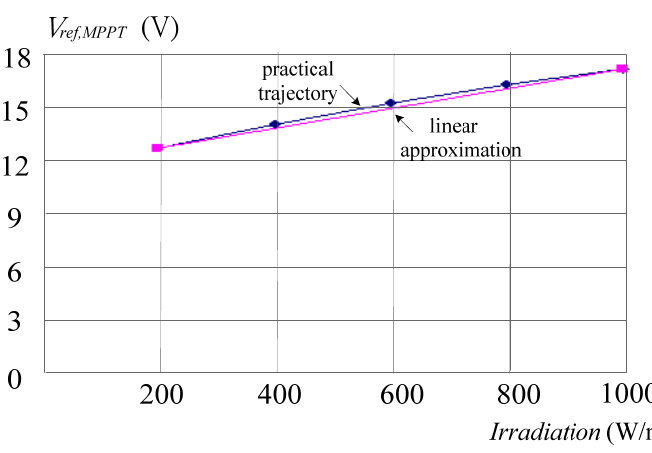
versus irradiation S ref,MPPT